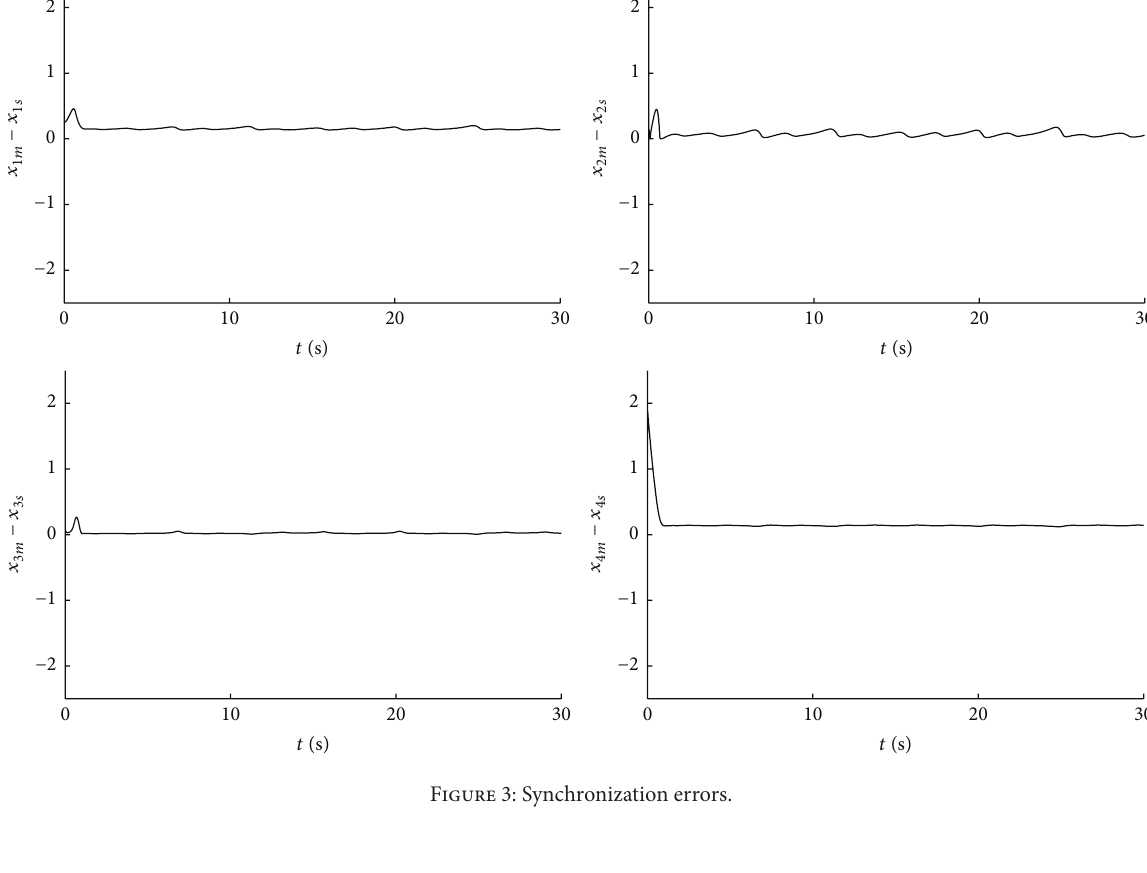
Figure 3: Synchronization